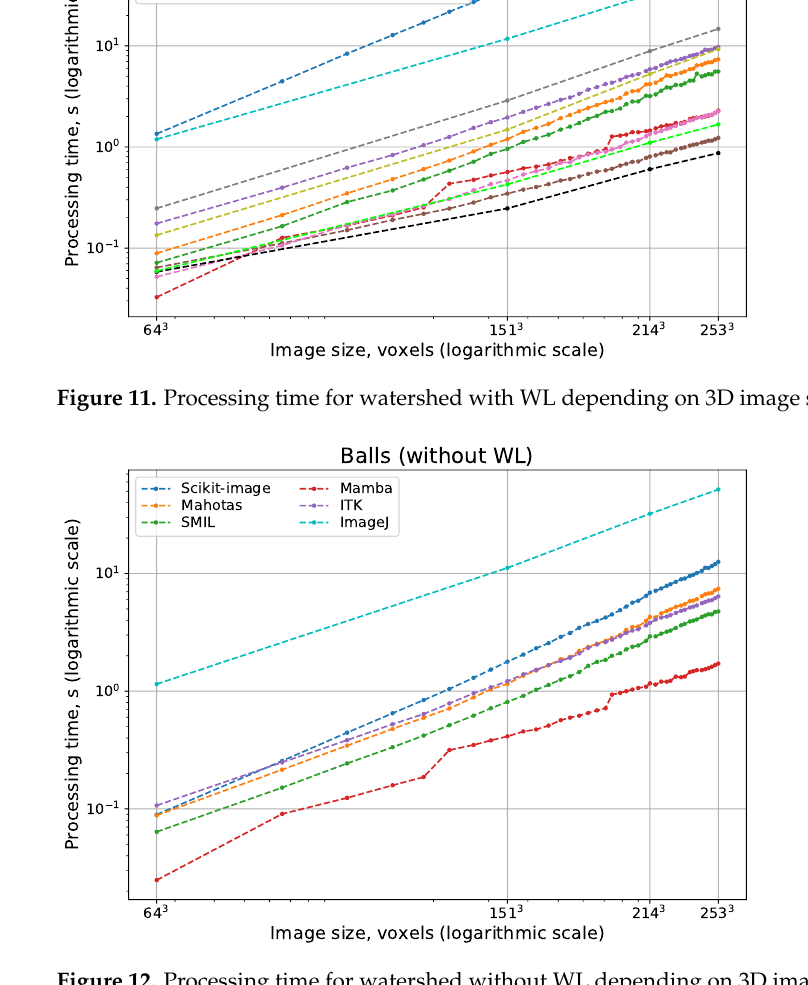
Figure 12. Processing time for watershed without WL depending on 3D image